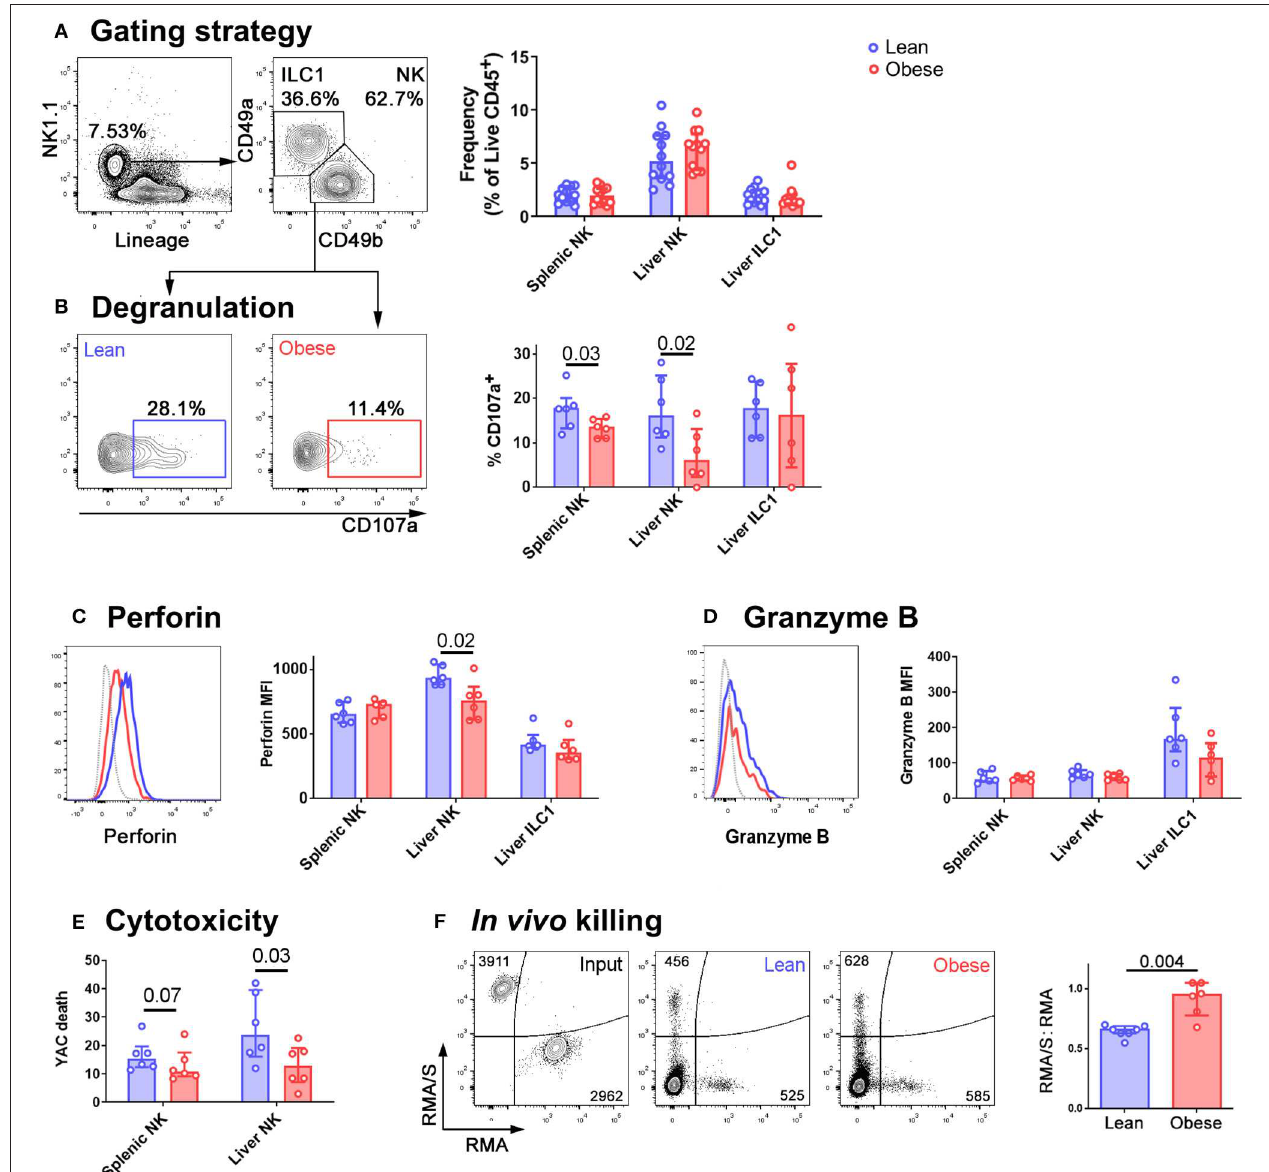
FIGURE 1 | NK cells in the livers of obese mice are less cytotoxic than those in lean mice. (A) Immune cells were isolated from mouse livers. NK cells were identified by scatter, and as live CD45 + Lineage-negative NK1.1 + CD49b + cells. ILC1 were identified as live CD45 + Lineage-negative NK1.1 + CD49a + cells. The frequency of NK cells and ILC1 as a percentage of live CD45 + cells in the spleens and livers of lean and obese mice is shown. n = 12 mice per group, medians and IQRs are shown. (B) Intrahepatic leukocytes were cultured for 4h in the presence of anti-CD107a and Brefeldin A. Representative CD107a staining of NK cells from a lean (left, blue) and an obese (right, red) mouse and summary data are shown. (C) Representative perforin staining in liver NK from a lean (blue trace) and an obese (red trace) mouse. MFI of perforin in splenic NK, liver NK, and liver ILC1 from lean and obese mice are shown. (D) Representative granzyme B staining in liver NK from a lean (blue trace) and an obese (red trace) mouse. Gray traces represent internal negative controls. MFI of granzyme B in splenic NK, liver NK, and liver ILC1 from lean and obese mice are shown. (E) NK cells were sorted from the spleens and livers of lean and obese mice and cultured with the cancerous NK cell target line YAC-1. YAC-1 death at 24h is shown. (F) CTV-labeled RMA/S (NK cell targets) CTB-labeled RMA (recovery control) cells were mixed in a 1:1 ratio and intravenously injected into lean or obese mice. Representative input cells (leftmost, black) and recovered cells from lean (center, blue) and obese (rightmost, red) mice are shown. The RMA/S:RMA ratio in recovered splenocytes, normalized to input ratio, is shown. For panels (B–F) , n = 6 mice per group; significance was determined using Mann Whitney U -Tests; medians and IQRs are